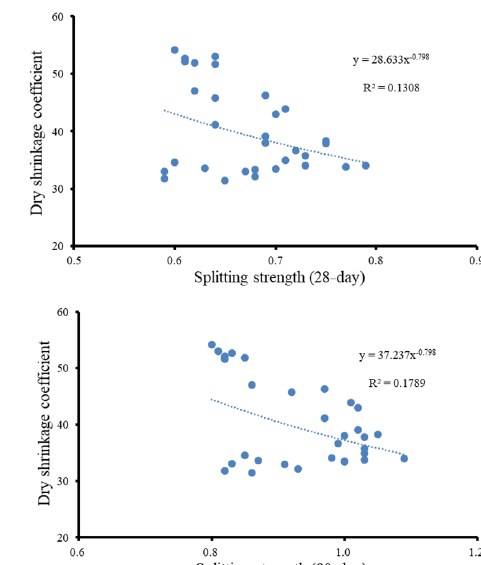
Figure 10. Relationships between compressive strengths and temperature shrinkage coefficients. Figure 11. Relationships between spliing strengths and temperature shrinkage coefficients.